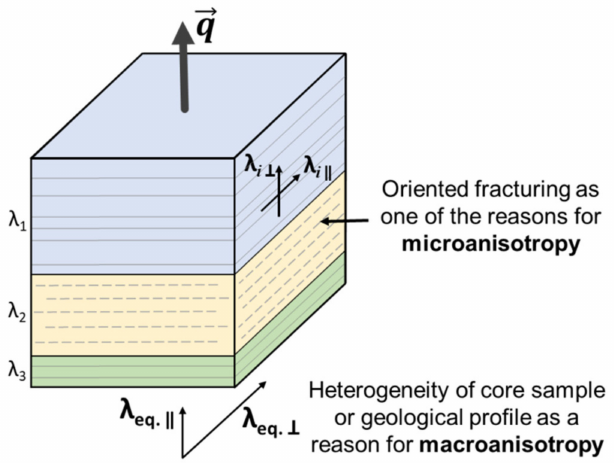
Figure 4. The reasons for the anisotropy of rocks that were accounted for during the determi- nation of the equivalent thermal conductivity required to calculate the heat flow density. λ eq .— macroanisotropy, λ i ⊥